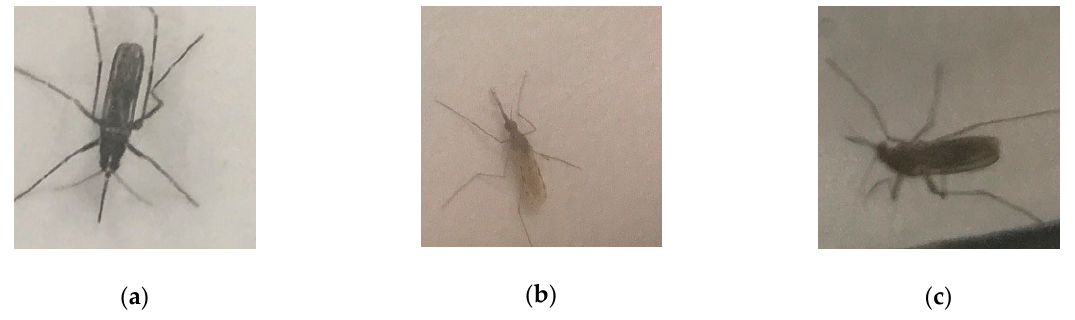
Figure 3. Clipped mosquito from the images captured using a smartphone: ( a ) Aedes albopictus , ( b ) Anopheles stephensi , and ( c ) Culex pipiens pallens .